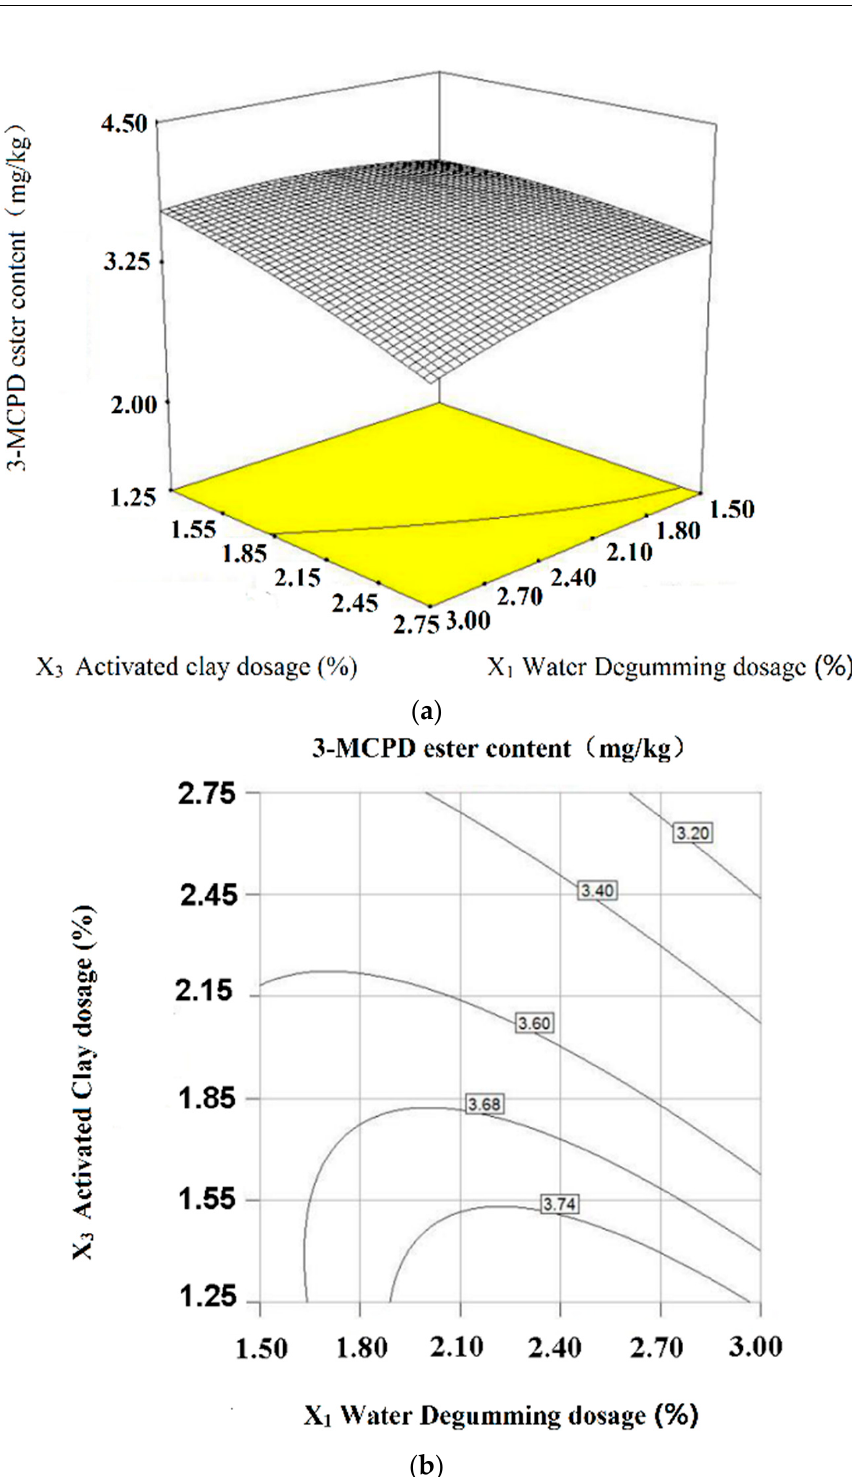
Figure 4. Response surface curves ( a ) and contours ( b ) of degumming water and activated clay towards on 3-MCPD ester (interactions of X 1 X 3 , p < 0.05).